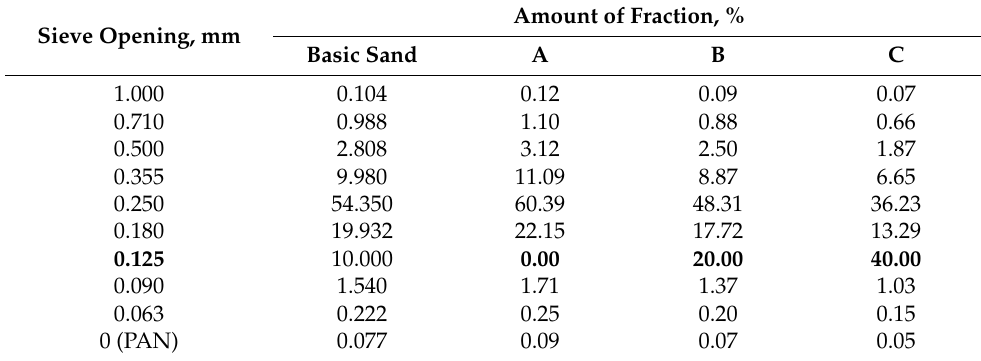
Figure 1. Results of the sieve analysis of the original sand used to prepare samples. Table 1. Proportion of different fractions mixed to obtain the three batches of measurement.